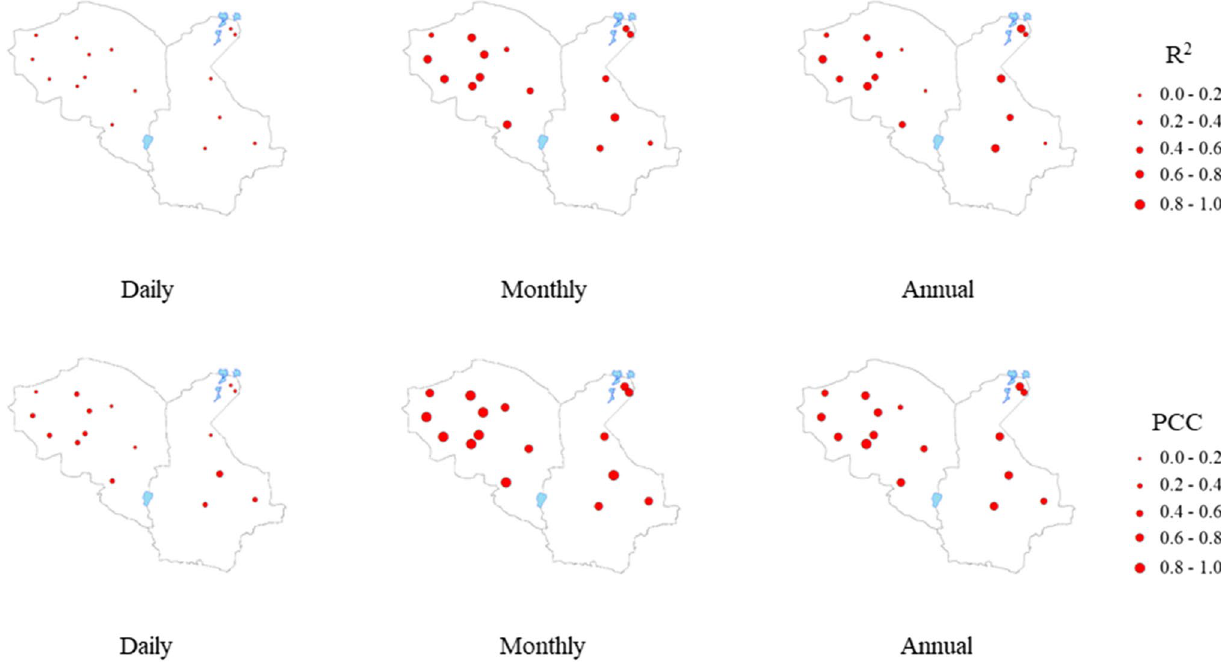
Fig. 3 Comparison of CHIRPS precipitation estimation with rain gauge data using R 2 and